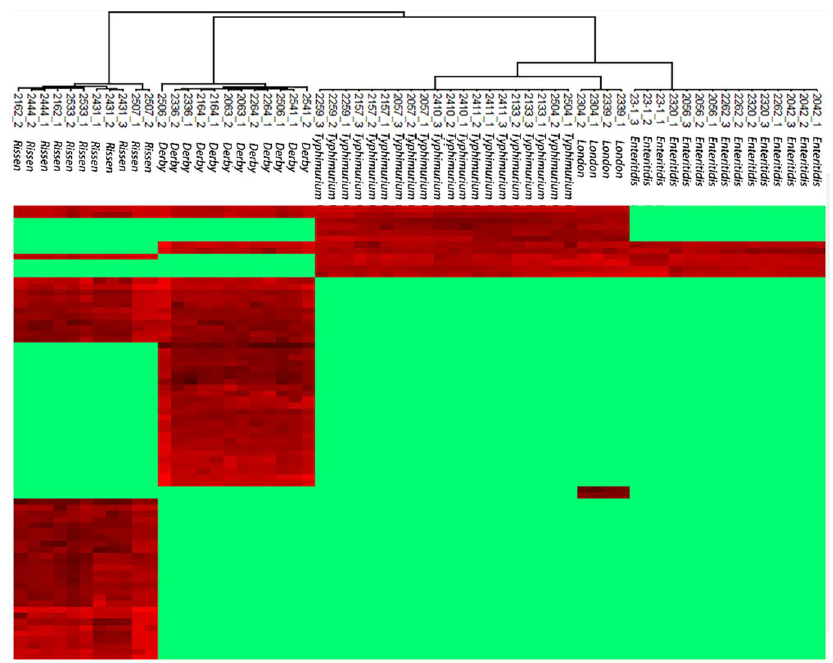
Figure 2. Hierarchical cluster analysis with 53 peptide markers in training group. Twenty-five iso- lates from five serotypes were divided into five clusters without overlap.